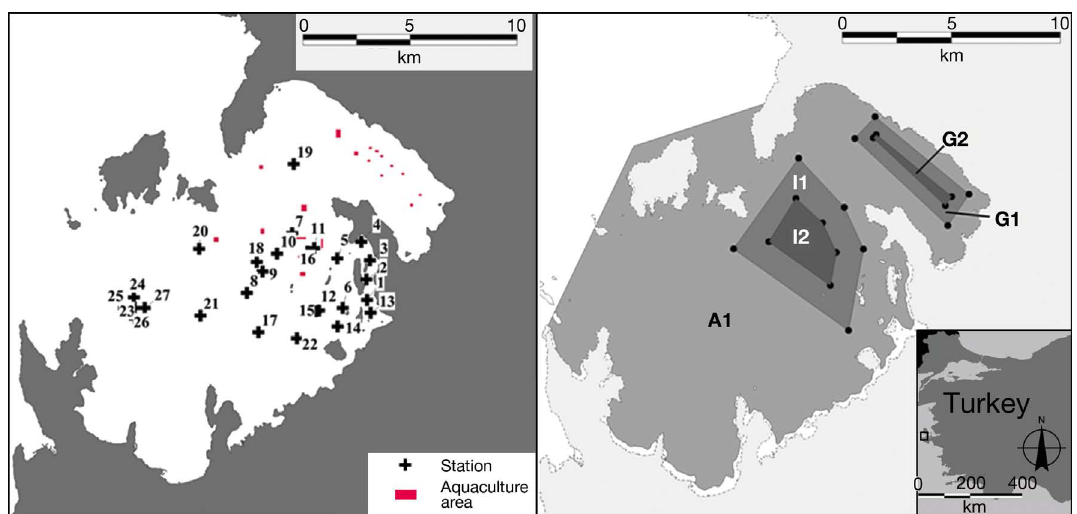
Fig. 1. Distribution of (a) sampling stations and (b) aquaculture impact zones. Inset shows the study area (rectangle). Impact zones were defined and classified for 2 cases and 2 regional groups: Region I (central Ildırı Bay) and Region G (central Ger- ence region of the bay). In the first case (I1 and G1), borders of the impact zones were 300 m away from the margins of the cage platforms. In the second case, the impact zones were narrowed to a distance of 1.2 km (I2) and 0.6 km (G2) inside the borders of both zones of the first case. Zone A1 in panel b represents the entire